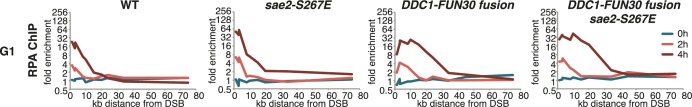
The DDC1-FUN30 fusion specifically enhances long-range resection in G1, while the sae2-S267E phospho-mimicry leads to a small increase in resection initiation.The sae2-S267E mutant has little effect on the spreading of DNA end resection in G1, but slightly stimulates the RPA fold enrichment in WT and the DDC1-FUN30 fusion mutant. This suggests that sae2-S267E in contrast to the DDC1-FUN30 fusion does not affect long-range resection. DNA end resection in the indicated strains was analysed by RPA ChIP as in Figure 5C but with G1 arrested cells.